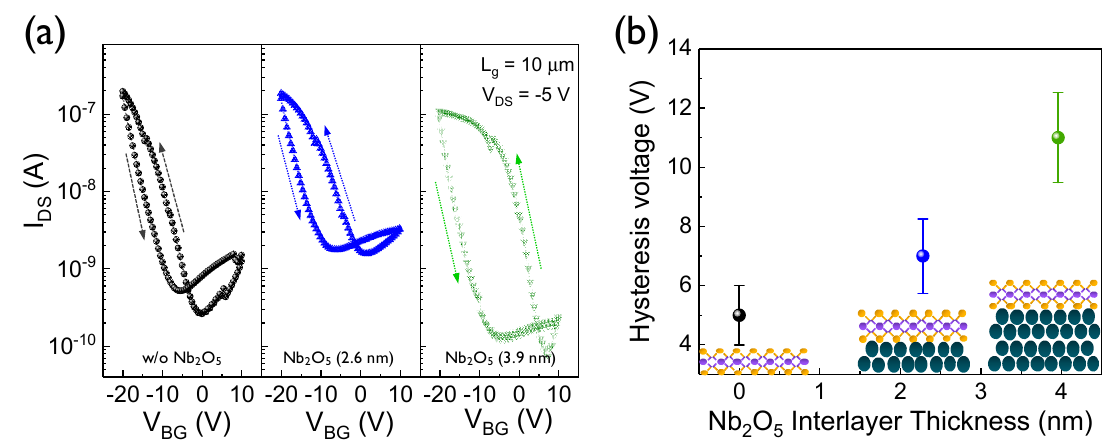
Figure 3. ( a ) Hysteresis behaviors of the two-dimensional (2D) WSe 2 -NbSe 2 hetero-structure transistor devices with different Nb 2 O 5 interlayer thickness. ( b ) Hysteresis window voltage as a function of the Nb 2 O 5 interlayer thickness for the 2D WSe 2 -NbSe 2 devices.